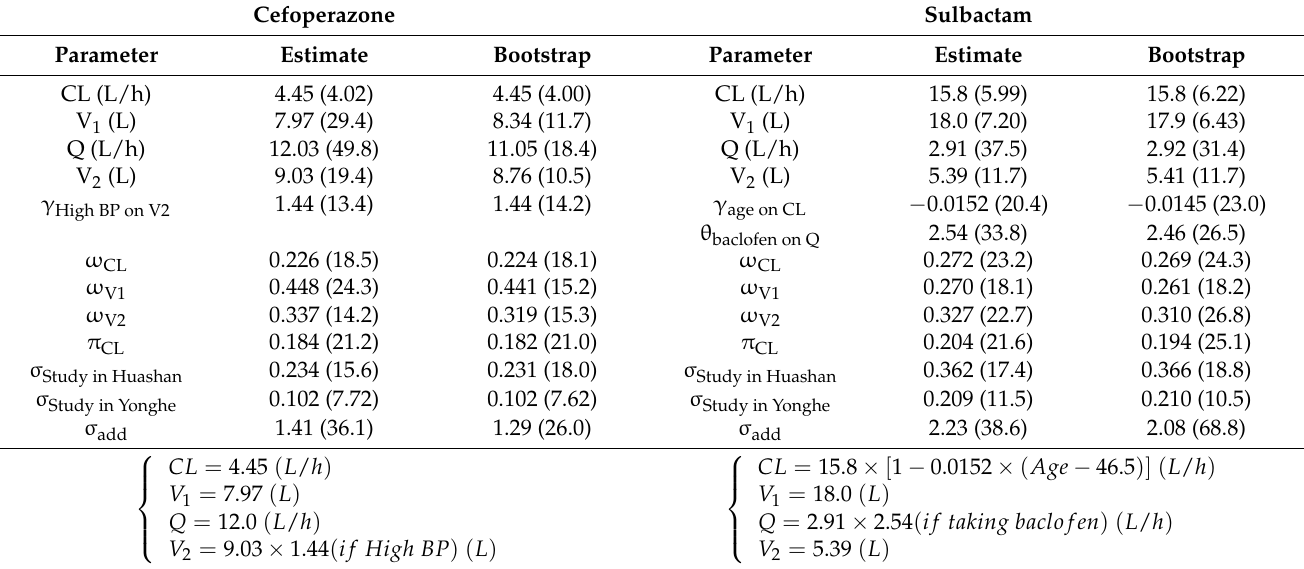
Table 2. PPK model of cefoperazone/sulbactam and the parameter